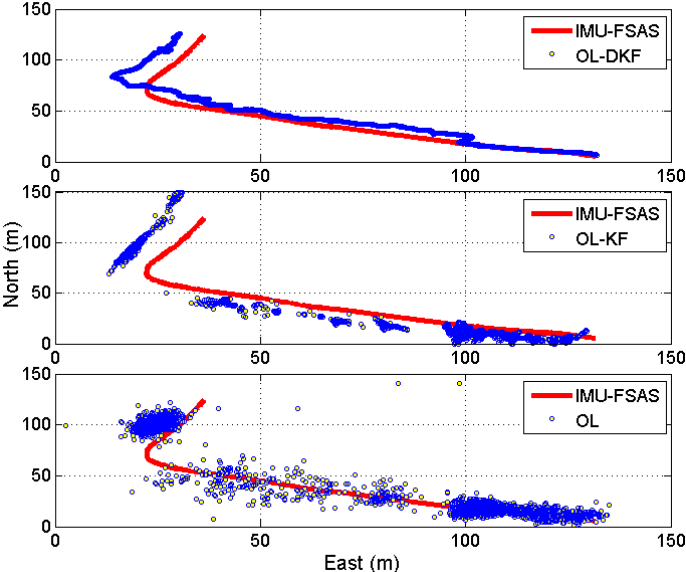
Figure 28. Trajectories of OL-DKF, OL-KF, OL and IMU-FSAS of roads in the city canyon test.